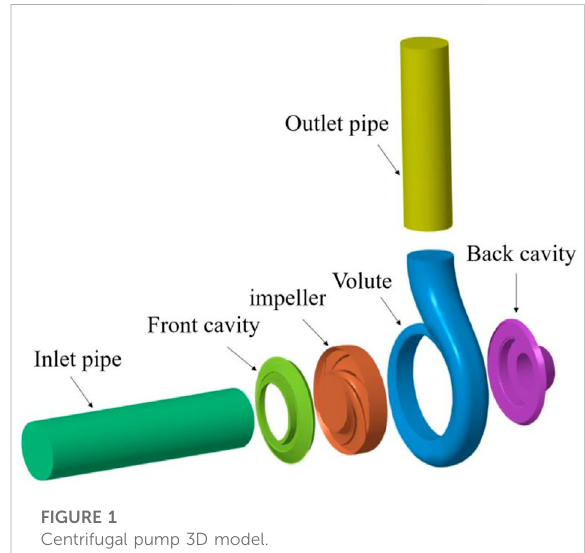
FIGURE 1 Centrifugal pump 3D